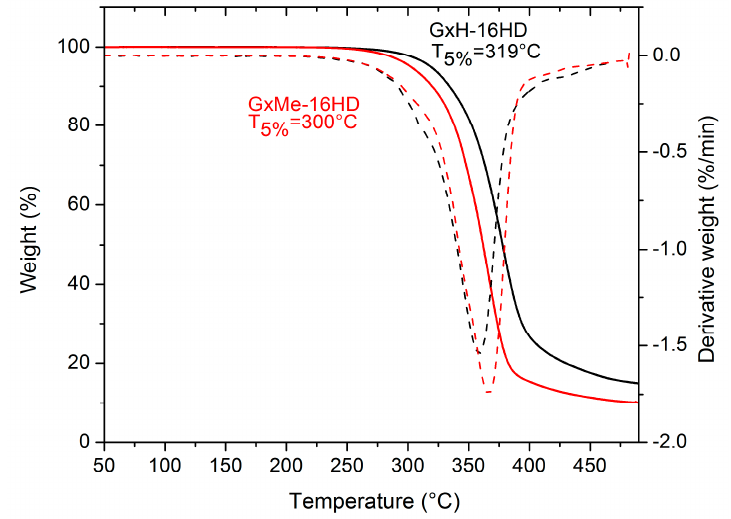
Figure 7. Weight loss of GxMe-16HD and GxH-16HD determined by thermo-gravimetrical analysis (TGA).